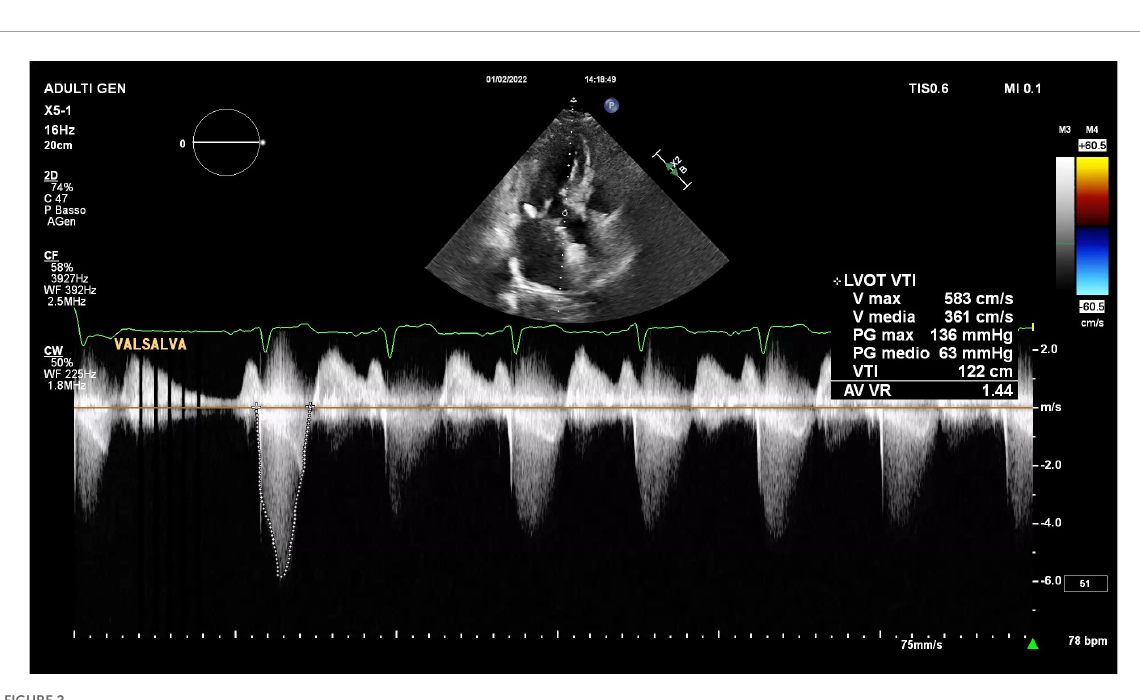
N. 32 (Edwards Lifesciences, Irvine, CA, USA) was